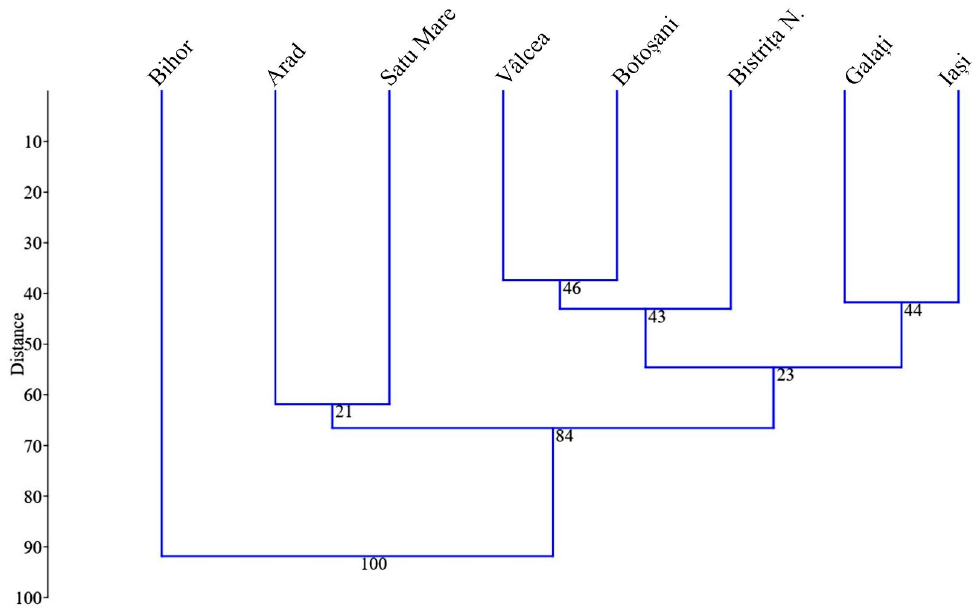
Figure 6. The hierarchical dendrogram of cluster analysis based on the analysed parameters of the R. pseudoacacia provenances.